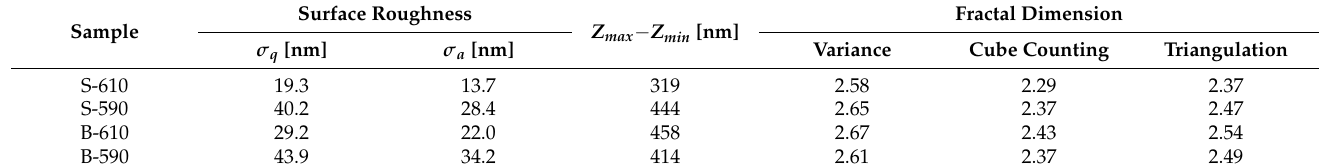
Table 2. Result of AFM images analysis: surface roughness parameters σ q and σ a , z range Z max − Z min , fractal dimension calculated by variance method, cube counting method. and triangulation method. Results are obtained by Gwyddion software [18].